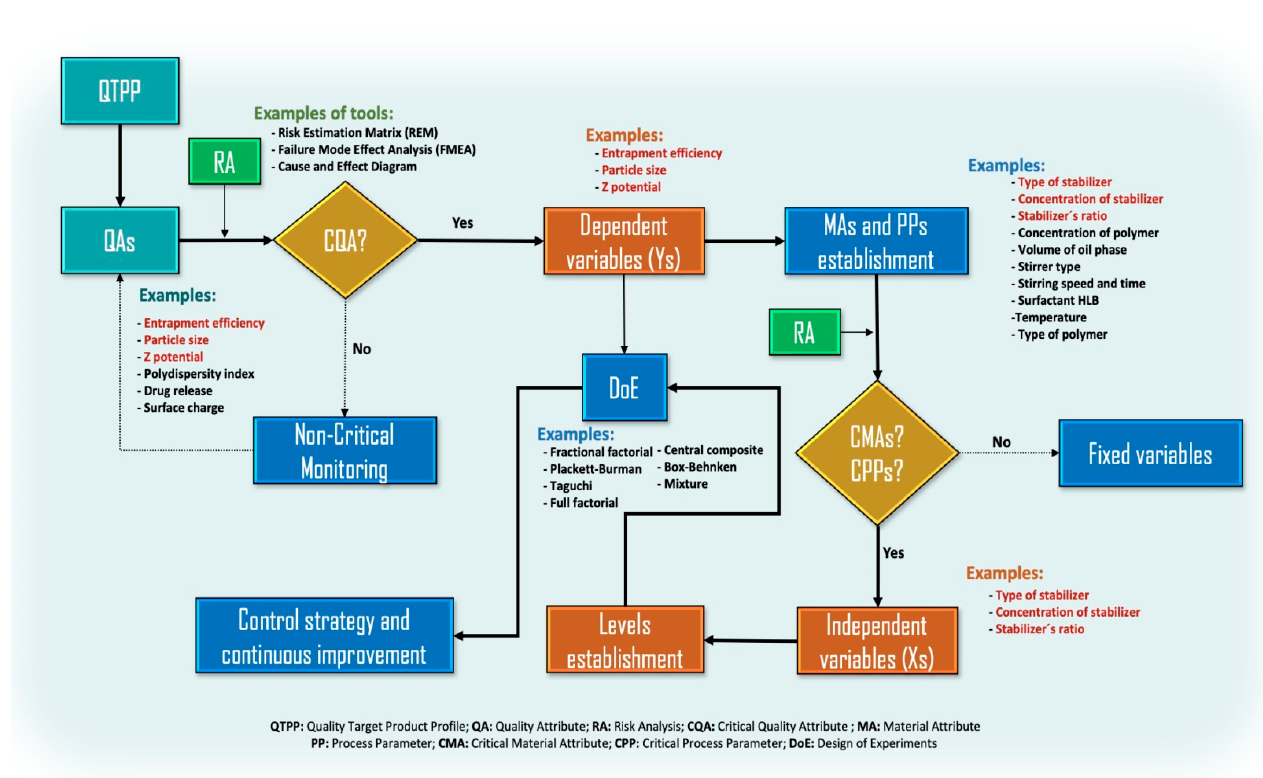
Figure 5. General steps for implementing QbD in the suspension of NP considering the variables related to or affected by surfactants as stabilizers.